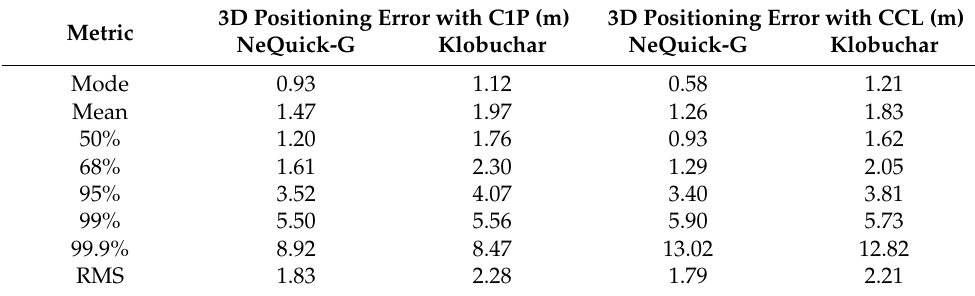
Figure 6. CDF of the PVT errors obtained by NeQuick-G and Klobuchar using code-pseudorange measurements and CCL measurements. The left panel depicts the CDF of the PVT errors when the 3D errors go up to 5 m. The right panel depicts the CDF of the PVT errors when the CDF values ranges from 90 to 100%. Table 4. Percentile values of the PVT 3D positioning errors obtained with NeQuick-G and Klobuchar using code-pseudorange measurements and CCL measurements.